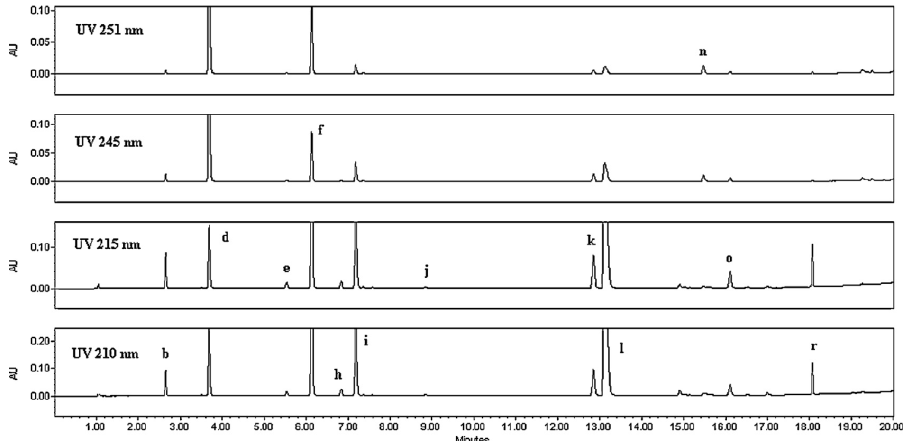
Figure 5. UHPLC separation of a sample categorized as southwest Asian heroin. UHPLC separation of a standard mixture of: (b) morphine, (d) acetaminophen, (e) codeine, (f) caffeine, (h) O3-monoacetylmorphine, (i) O6-monoacetylmorphine, (j) lidocaine, (k) acetylcodeine, (l) heroin, (n) papaverine, (o) noscapine, and (r) methorphan [32]. “Reprinted with permission from Ref. [32]. Copyright